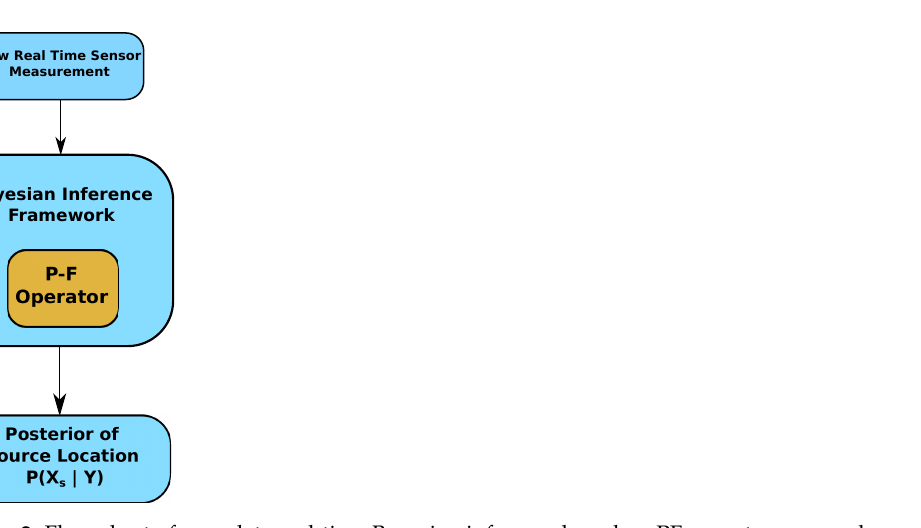
Figure 2. Flow chart of complete real-time Bayesian inference based on PF operator